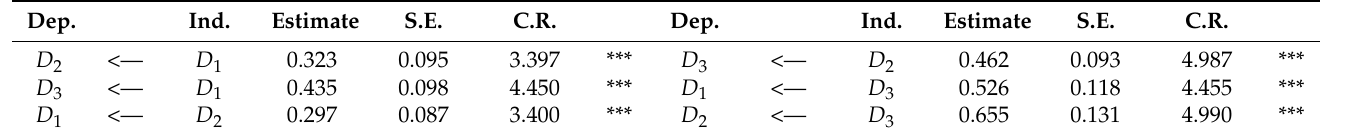
Table 3. The direct influence of the dimensions.